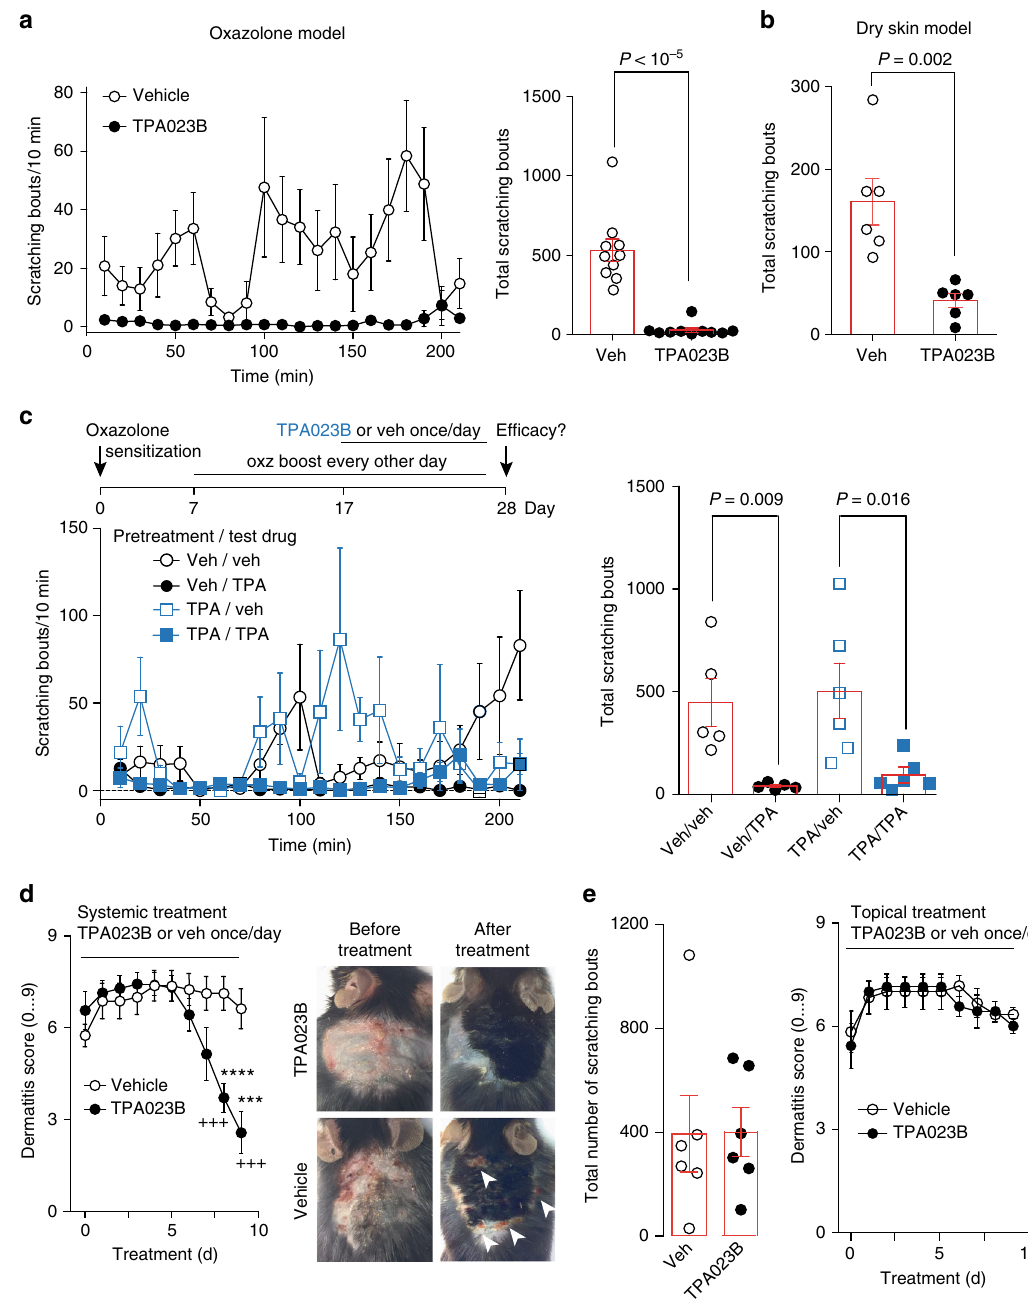
Fig. 8 Antipruritic actions of TPA023B in chronic itch models. a Oxazolone model of chronic atopic-like dermatitis. Scratching bouts after injection of TPA023B (1 mg kg − 1 , i.p.) over time (left). Total numbers of scratching bouts between 15 and 210 min after TPA023B/vehicle administration (right). Unpaired two-sided t -test, n = 10 mice per group. b Same as a but dry skin model of dermatitis, n = 6 mice per group. c Lack of tolerance development after 10 day treatment with TPA023B (TPA, 1 mg kg − 1 , i.p. once daily). Two-way ANOVA (pretreatment x treatment), F(1,1) = 0.96, P = 0.34. Two-sided t -test indicates similar antipruritic effects in vehicle and TPA023B pretreated mice, n = 6 (TPA/TPA), n = 5 for all other groups. d Dermatitis score. Chronic systemic treatment with TPA023B (1 mg kg − 1 i.p., once per day) starting on day 11 of oxazolone exposure. Oxazolone challenges were continued during TPA023B treatment every other day. Only mice with a dermatitis score of 5 or higher on day 11 were included. In TPA023B-treated mice the dermatitis score decreased from day 6 of treatment onwards (F(9,54)> 38.7; P < 0.026 to P < 0.001) (left), but remained almost constant in vehicle-treated mice (right). Mixed repeated measures ANOVA revealed a signi fi cant treatment x time interaction F(9,117) = 22.6; P < 0.001 for day 8 and 9 ( +++ ). Differences between both treatment groups were signi fi cant at day 8 and 9. *** P = 0.0009 and **** P < 00001. Photographs show the same mice before treatment (left) and after 9 days of treatment (right). e Chronic topical treatment (0.3 µ M TPA023B in 100 µ l, once per day). Left: total number of scratching bouts between 15 and 210 min after TPA023B on day 9 after treatment begin. Unpaired two-sided t-test, P = 0.97, n = 6 mice per group. Right: same as left but dermatitis score (mixed repeated measures ANOVA treatment × time interaction F(9,99) = 0.61; P = 0.78; n = 6 and 7, for vehicle and TPA023B, respectively). Error bars indicate